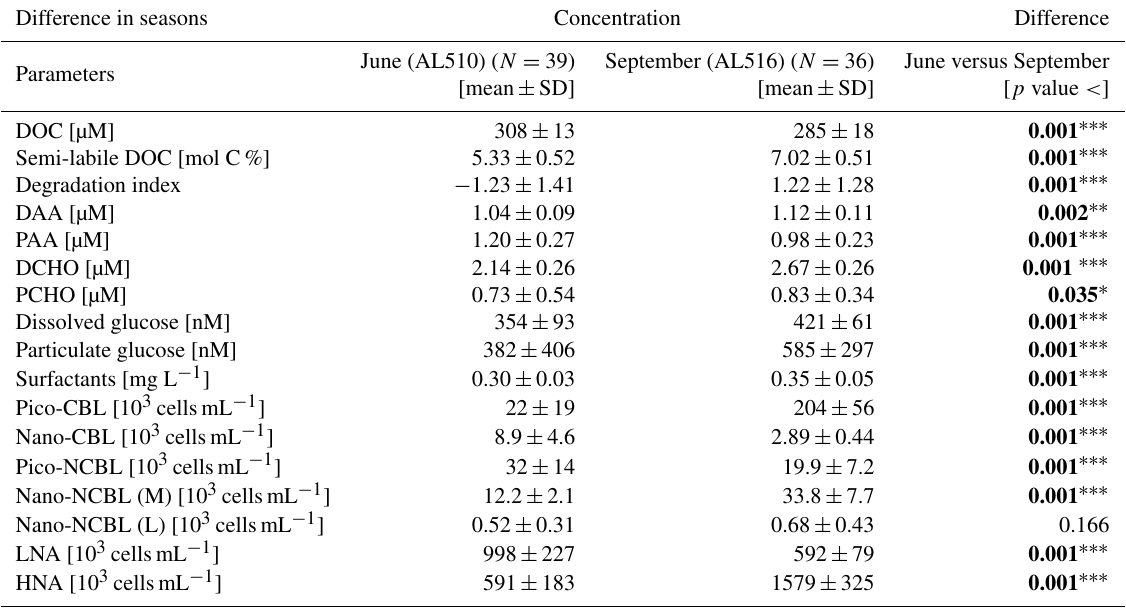
Table A2. Concentrations and statistics of differences (Wilcoxon rank test) for the summer (AL510) and autumn (AL516) sample set. Bold numbers indicate significance while the asterisks mark the level of significance ( ∗ p value < 0 . 05; ∗∗ p value < 0 . 01; ∗∗∗ p value < 0 .